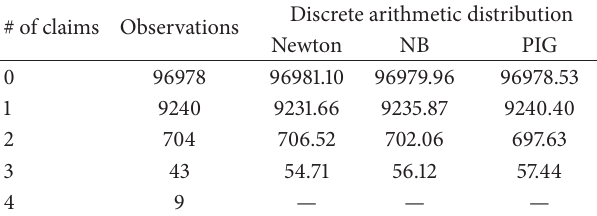
Table 1: Data set and MLE fit with the last two regrouped classes.